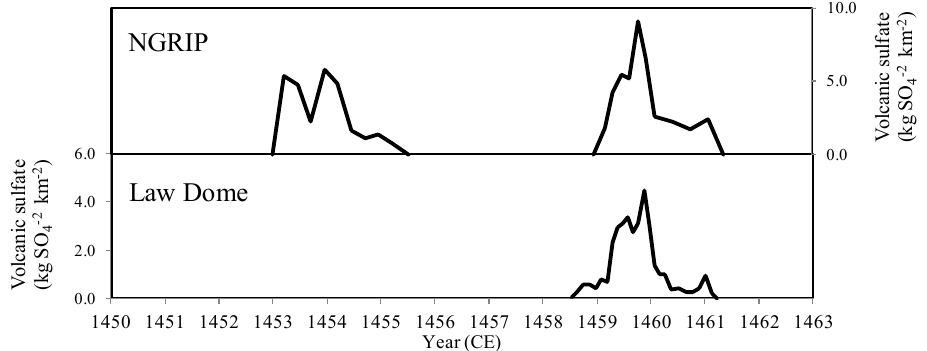
Fig. 3. The Law Dome and NGRIP volcanic sulphate records between 1450–1460. The two distinct volcanic peaks in NGRIP are dated 1453 and 1458 CE; the single clear peak in Law Dome is dated 1458 CE. The two NGRIP peaks are evidence of two separate volcanic eruptions during the 1450s